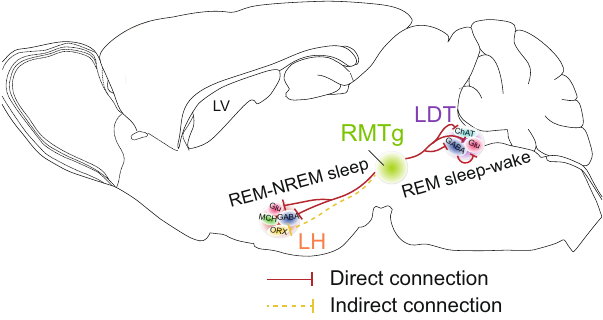
Fig. 8 | Hypothesis for neural mechanisms of RMTg GABAergic neurons sup- pressing REM sleep through the LDT/LH. RMTg GABAergic neurons inhibited cholinergicand/orGABAergicneuronsintheLDTtoceaseREMsleep.Activationof RMTgGABAergicneuronsinhibitedGABAergicinterneuronsintheLDT,whichthen disinhibited glutamatergic neurons in the LDT to facilitate REM sleep – wake tran- sitions. Activation of RMTg GABAergic terminals in the LH facilitated REM – NREM sleep transitions through direct inhibition of glutamatergic and/or GABAergic neurons and/or through indirect synaptic connection with orexin neurons. RMTg rostromedial tegmental nucleus, LDT laterodorsal tegmentum, LH lateral hypo- thalamus, LV lateral ventricle, ChAT cholinergic neurons, Glu glutamatergic neu- rons, ORX orexin neurons, MCH melanin-concentrating hormone